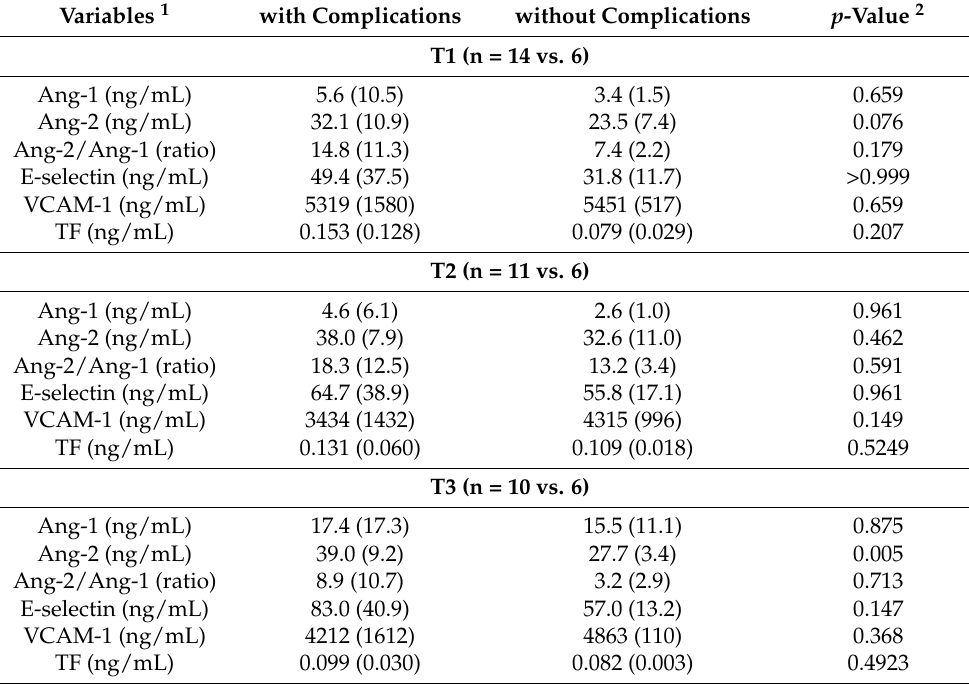
Table 4. Soluble endothelial markers and early hemodynamic and respiratory complications in very preterm